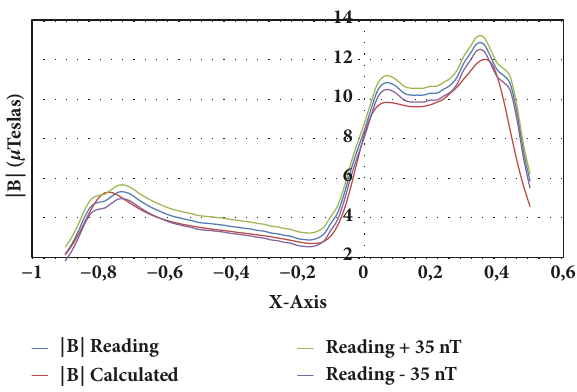
Figure 8: Calculated and measured values of the magnetic field | B | . The instrument tolerance is also